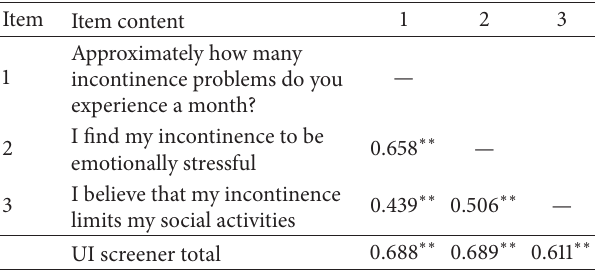
Table 3: Interitem correlation